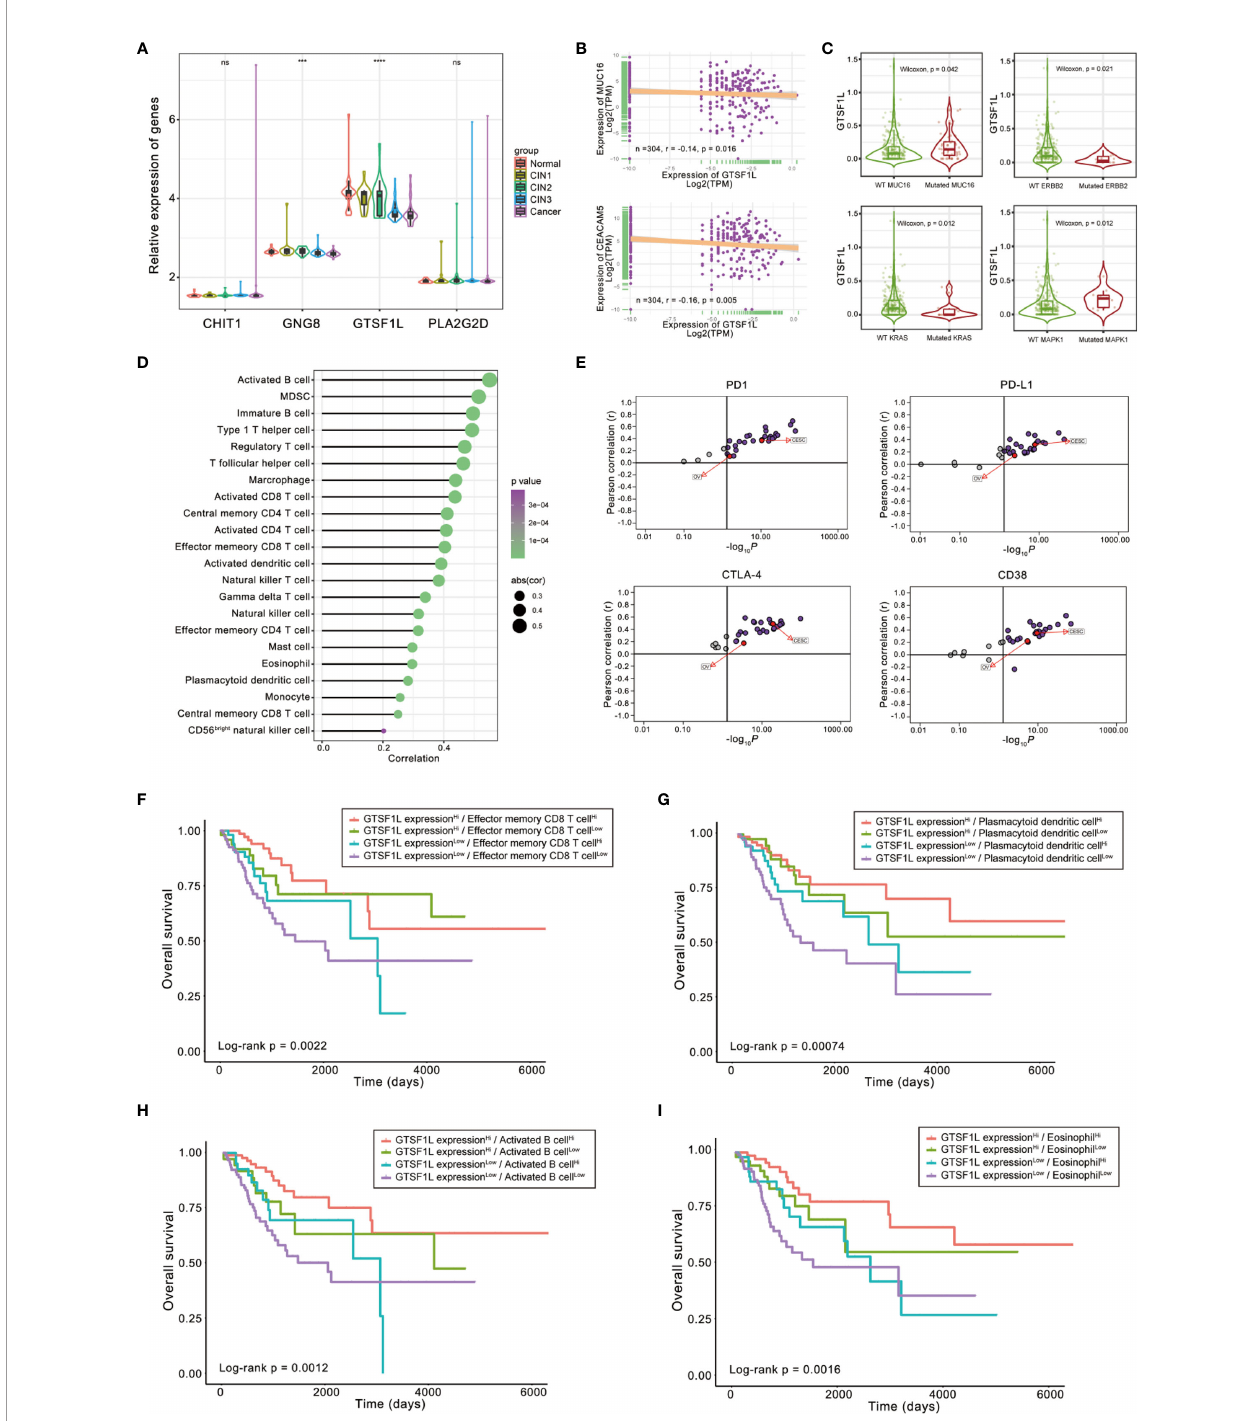
FIGURE 9 | The role of GTSF1L in immune contexture and clinical practice. (A) Differences in the expressions of the four immune-related genes in GSE63514, which involves 128 cervical specimens, ranging from normal cervix to cervical cancer (Kruskal – Wallis test, *** p < 0.001; **** p < 0.0001, ns, not signi fi cant). (B) Scatterplots depicting the negative correlation between GTSF1L expression and clinical biomarkers involving CA125 (MUC16) and CEA (CEACAM5) in the TCGA-CESC cohort. The Spearman correlation is shown ( p < 0.05). (C) Difference in GTSF1L expression among speci fi c gene-mutated conditions such as MUC16, ERBB2, KRAS, and MAPK1 (Wilcoxon test, p < 0.05). (D) Spearman correlation analysis of GTSF1L expression and tumor-in fi ltrating cells. (E) The Pearson correlation analysis of GTSF1L expression and immune checkpoints, such as PD1, PD-L1, CTLA-4, and CD38, in all sorts of cancers of TCGA. (F – I) Kaplan – Meier curves for patients in the TCGA-CESC cohort strati fi ed by both GTSF1L expression and in fi ltration levels of the four prognostic immune cells. Log-rank test, p <